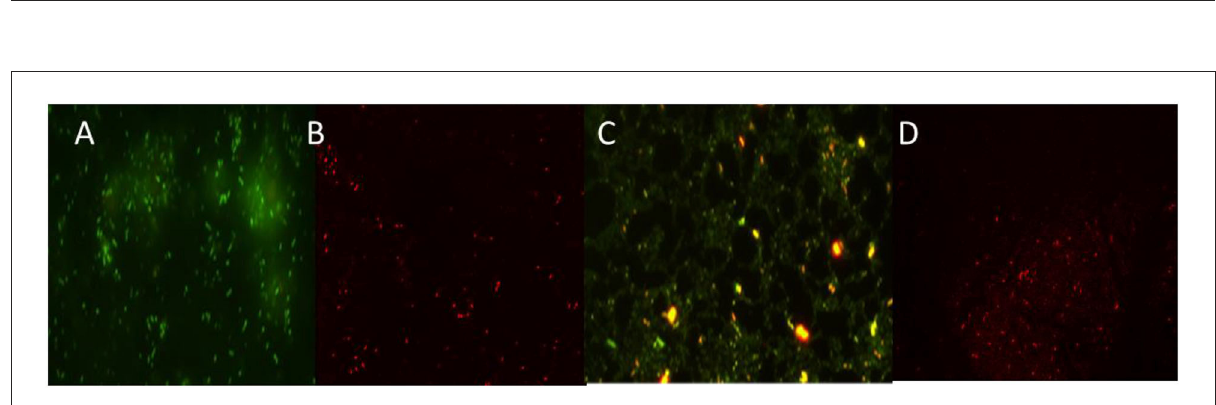
FIGURE10 Fluorescence images of untreated and treated sessile cells by ZnO NPs of P. gingivalis (A,B) and A. faecalis (C,D)